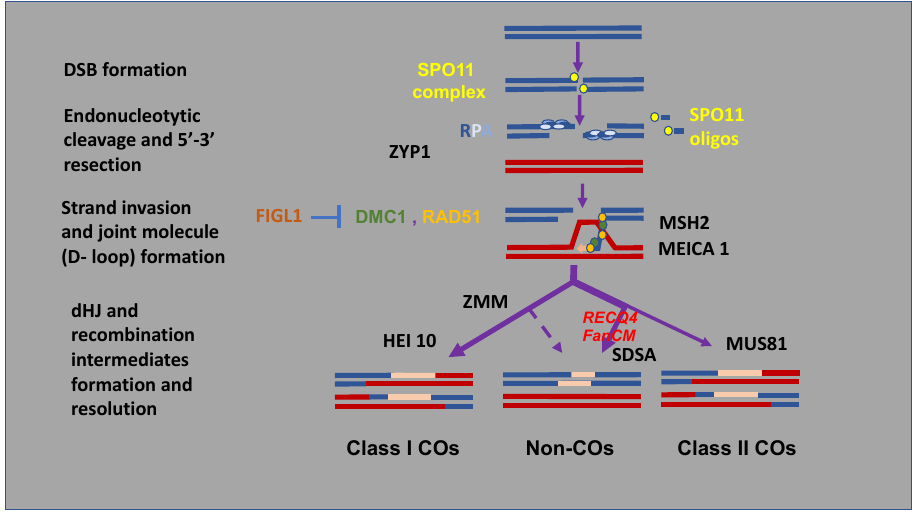
Figure 2. A simplified view of pathways for repairing Meiotic Chromosomal Double-Strand Breaks (DSB) and their modulation by altering key regulatory genes. Meiotic recombination is initiated within the mother cells of microspores and megaspores by the self-induction during the prophase of the first division of meiosis of several hundreds of DNA DSBs by the SPO11 complex. Occurrence DSBs trigger the pairing of homologous chromosomes (blue and red bars). In the current model of DSB-associated DNA synthesis, the CO formation pathway proceeds mainly in repairing the DSB by homologous recombination using an intact chromatid of the paired homologous chromosome as a template. This pathway is initiated by the invasion of the 3 (cid:48) end of a single end of the DSB which initiates DNA synthesis on the homologous DNA molecule. The capture of the second end of the double-stranded break facilitates further synthesis using the 3 (cid:48) end on the other side of the break. A specific joint molecule structure linking the 4 strands of the 2 homologous chromosomes, the double Holliday junction (dHJ) is formed. The resolution of this structure usually leads to a reciprocal exchange of large DNA segments between two chromatids of the homologous chromosomes, the cross-over. This major pathway (class I) accounting for 90% of CO formation is called the ZMM ( ZIP1-4 , MSH4/5, and MER3 ) pathway. Other repair pathways pass through a variety of recombination intermediates that may mature in a minority way (10% in Arabidopsis) in so-called class II COs through MUS81 but mainly form non-COs, which can lead to gene conversions. Neosynthesized DNA appears in pink. Recent fine scale data in Arabidopsis, resulting from the sequencing of SPO11 oligonu- cleotides prepared from floral buds, indicate that hot spots (HS) of DSB formation occur preferentially in permissive, nucleosome-depleted regions like gene promoters, terminators, and introns where chromatin is accessible [15]. DSB HS are found in AT-rich